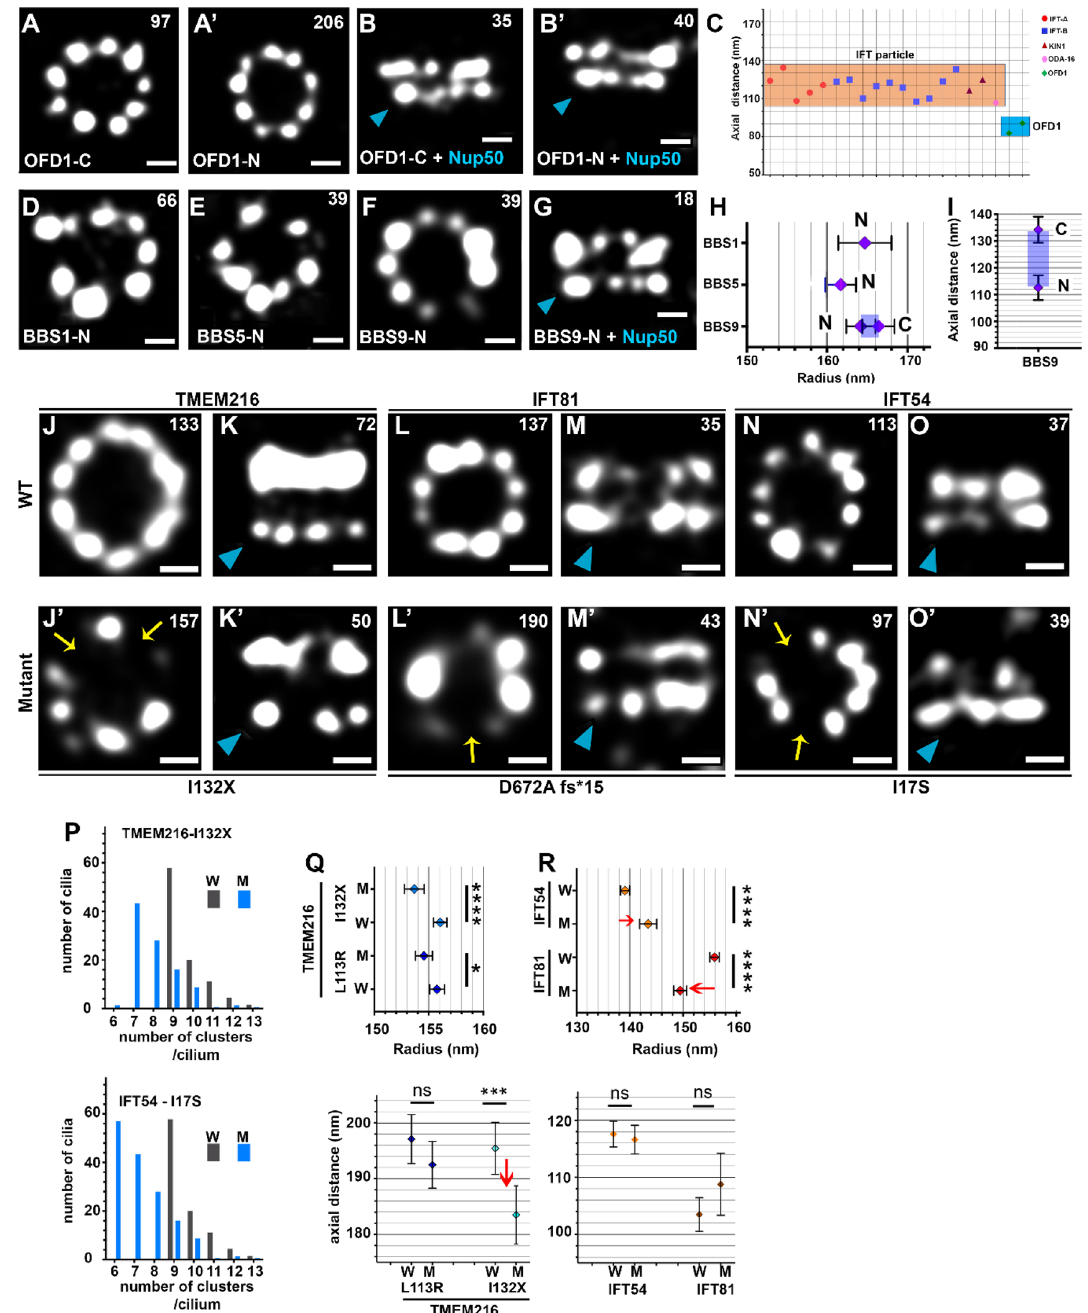
Figure 3. Localization of BBSome, OFD1, and selected TZ and IFT proteins carrying mutations causing ciliopathies in humans. ( A,A ′ ) STORM images of the top views of the centriole/basal body protein, OFD1, tagged at the C- and N-termini. ( B,B ′ ) Side views of OFD1 relative to NUP50 (indicated by a blue